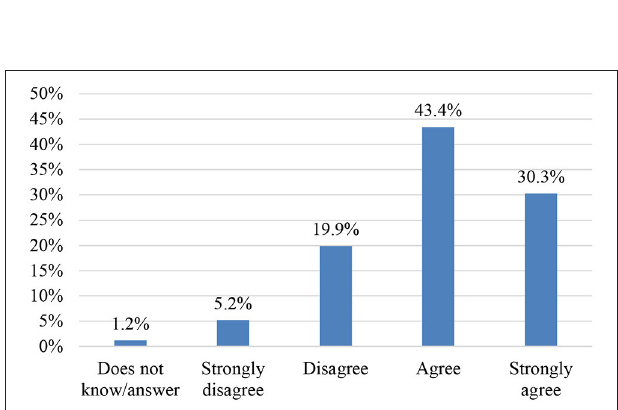
FIGURE 9 | Item 24. The use of ICTs could improve argumentative